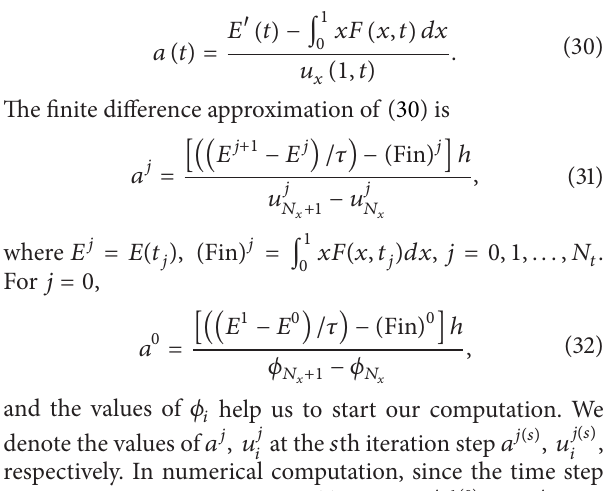
Figure 1: The analytical and numerical solutions of 𝑎(𝑡) when 𝑇 = 1 . The analytical solution is shown with dashed line.